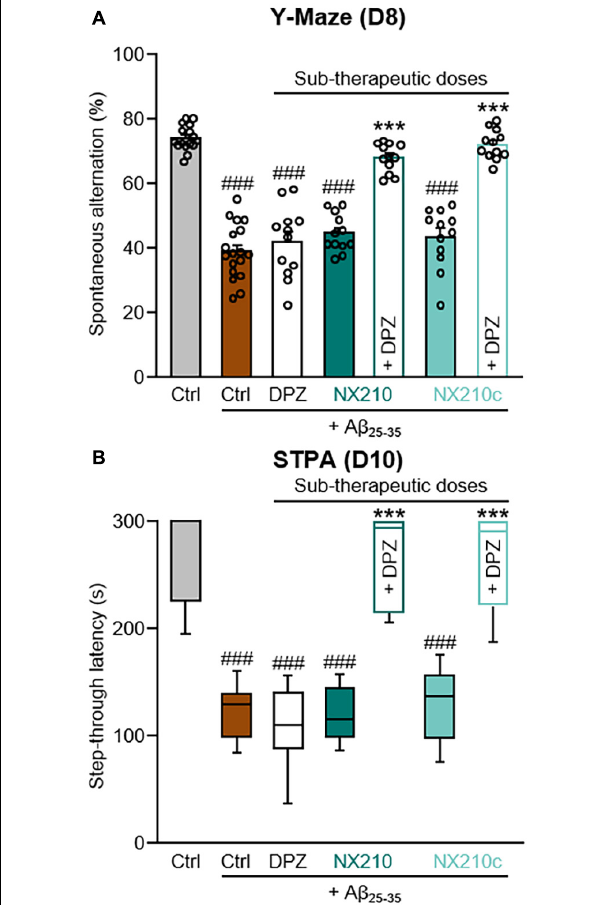
FIGURE 3 | Early stage daily treatment with a combination of sub-therapeutic doses of donepezil and NX210 or donepezil and NX210c prevents amyloid-beta 25 - 35 (A β 25 - 35 )-induced short-term cognitive impairments in mice. Mice were treated intraperitoneally once a day with vehicle, NX210 or NX210c (0.1 mg/kg), along with donepezil (DPZ, 0.25 mg/kg) administered orally one hour after intracerebroventricular injection of scrambled control peptides (Ctrl) or A β 25 - 35 oligomers. They were subjected to several behavioral tests to evaluate learning and memory. (A) Early stage daily treatment with a combination of sub-therapeutic doses of donepezil and NX210 or donepezil and NX210c restored working memory deficit, as shown by the increased number of spontaneous alternations in the Y-maze assessed at day 8 (D8) compared with A β 25 - 35 -injected mice treated with vehicle. The data are presented as means and SEM. (B) Early stage daily treatment with a combination of sub-therapeutic doses of donepezil and NX210 or donepezil and NX210c restored contextual long-term memory deficit, as shown by the increased time to enter the dark compartment in the step-through passive avoidance test performed at D10 compared with A β 25 - 35 -injected mice treated with vehicle. The data are presented as medians and interquartile range. (A,B) Kruskal–Wallis followed by Dunn’s test: ### p < 0.001 compared with Ctrl; *** p < 0.001 compared with A β 25 - 35 , n = 16 Ctrl, n = 18 A β 25 - 35 , n = 12 A β 25 - 35 + DPZ, A β 25 - 35 + NX210, A β 25 - 35 + NX210c, A β 25 - 35 + (NX210 + DPZ), A β 25 - 35 + (NX210c + DPZ).